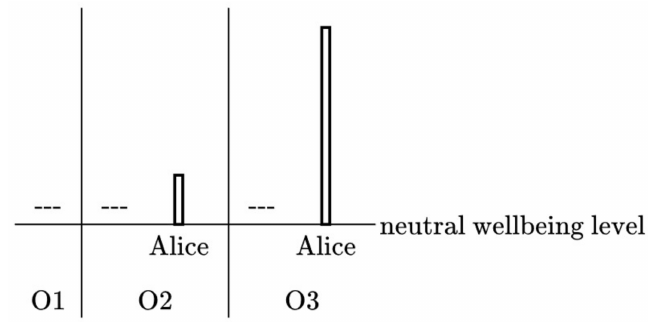
Figure 2. Counterexample to the principle of equal